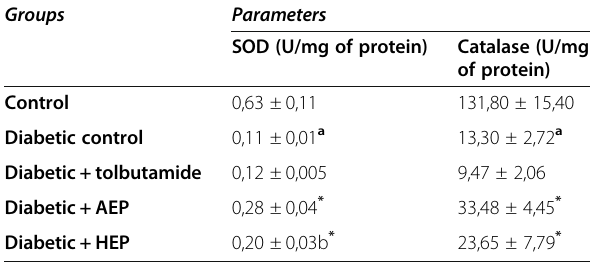
Table 9 Effects of peel extracts of I. wombolu on the erythrocyte activities of SOD and catalase